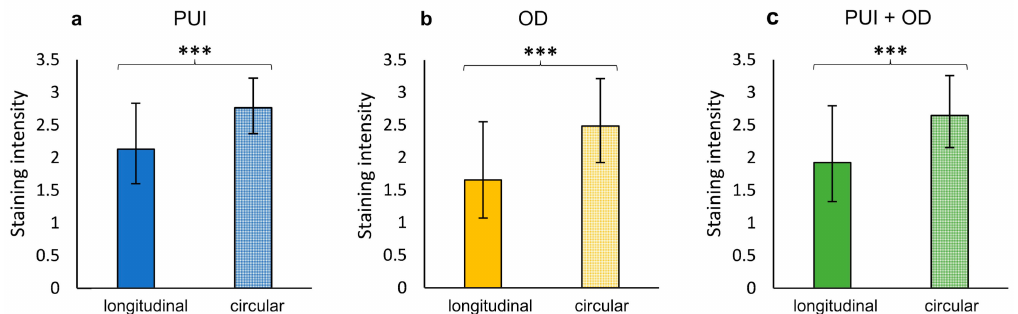
Figure 4. Comparison of OXTR IP staining intensity between myometrial layers (longitudi- nal/circular) for ( a ) PUI ( n = 12) and ( b ) OD ( n = 8), respectively, and ( c ) regardless of the group (PUI + OD). Results presented as mean ± SD. Bars with asterisks differ significantly (*** p <